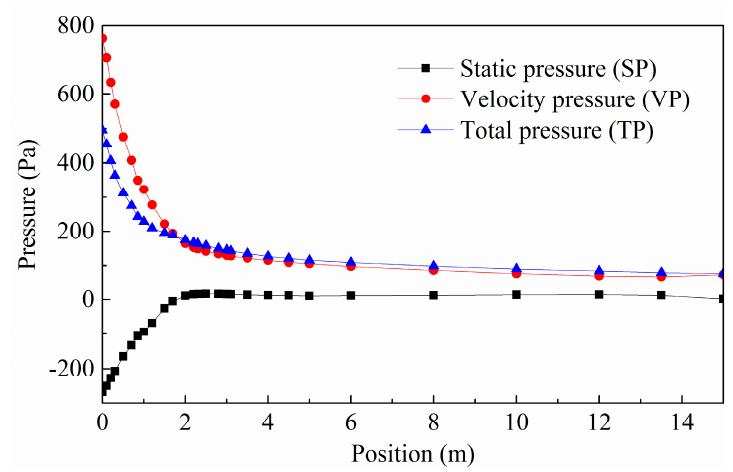
Figure 10. Velocity streamlines’ pressure parameters monitored in the return airway.